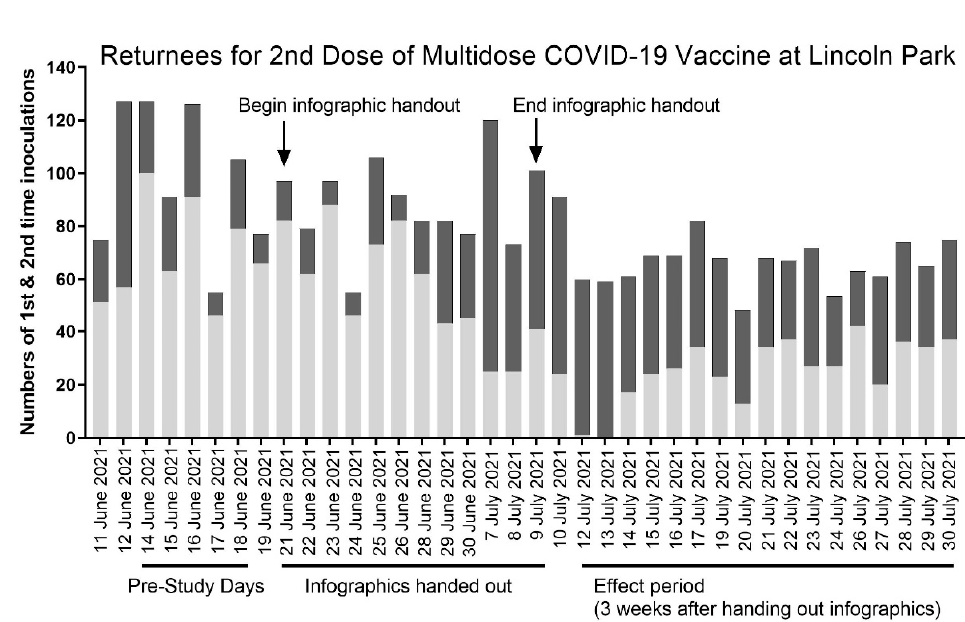
Figure 2. Anonymized site data from the Lincoln Park COVID-19 vaccine clinic in Los Angeles, CA, and the corresponding timeline of this study in which the COVID-19 infographic was distributed. One week prior to distributing the COVID-19 infographic (pre-study days), site records show triple the number of first-dose appointments (light gray bars) compared to second-dose appointments (dark gray bars). Three weeks after distributing infographics during the effect period, the number of second-dose appointments outnumbered first-dose appointments, on average, by 50%.